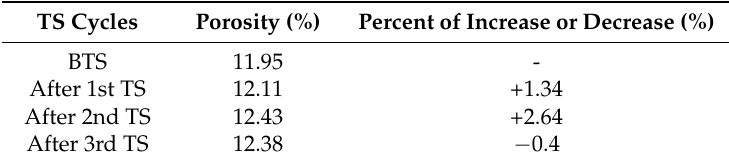
Table 3. Porosity results of core sample EF#5 before and after thermal shocking. TS: thermal shock; and BTS: before thermal